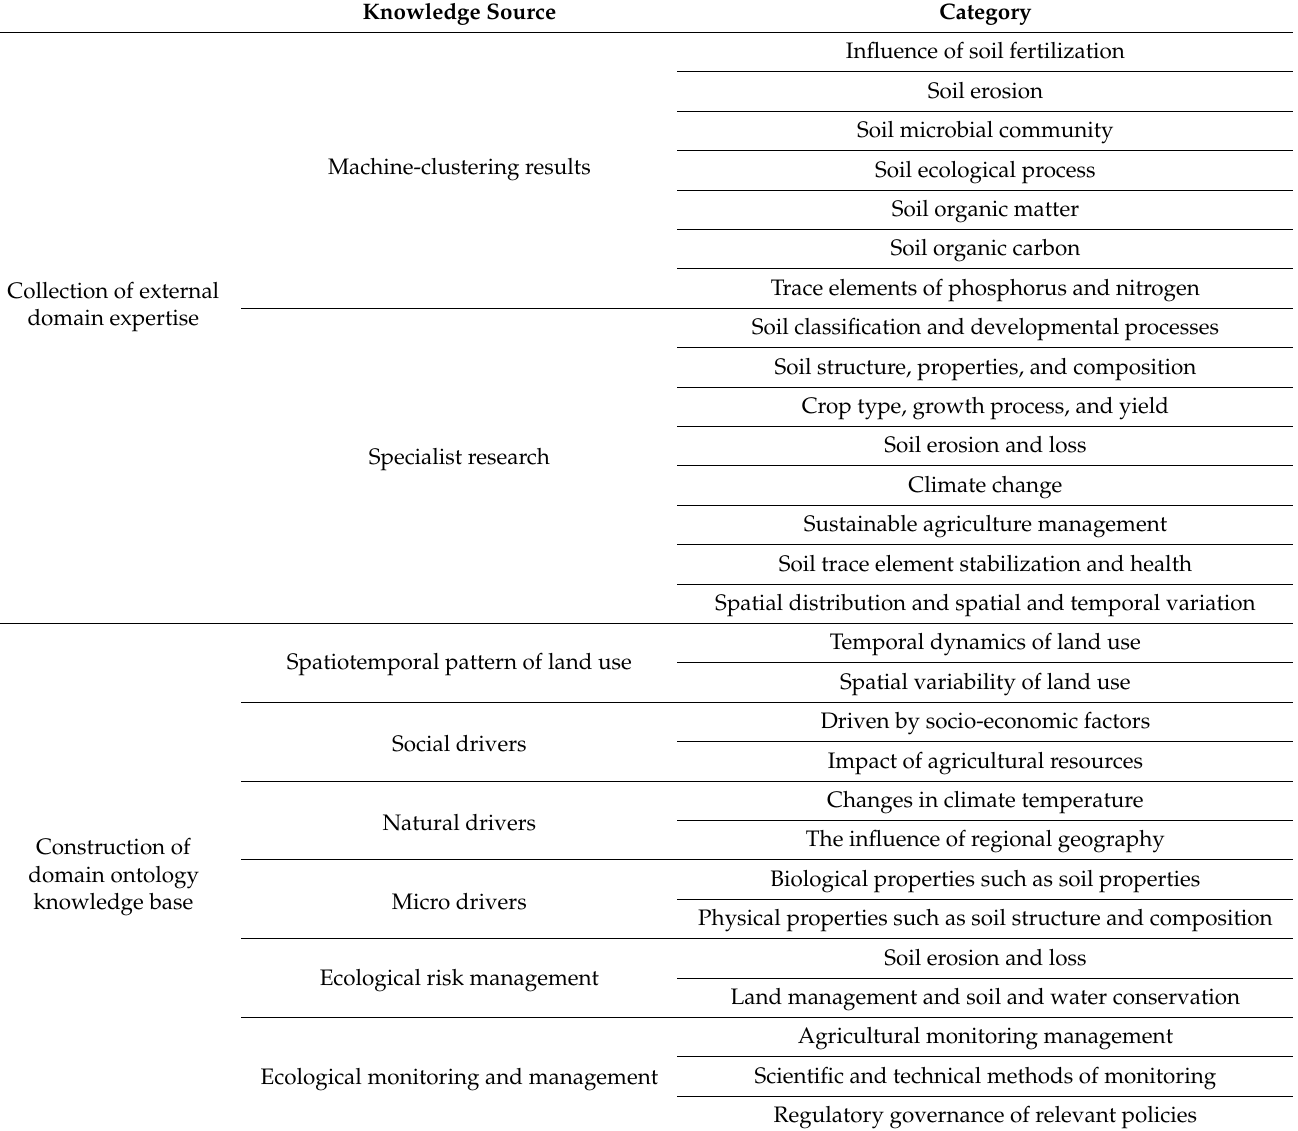
Table 3. Classification system based on expert